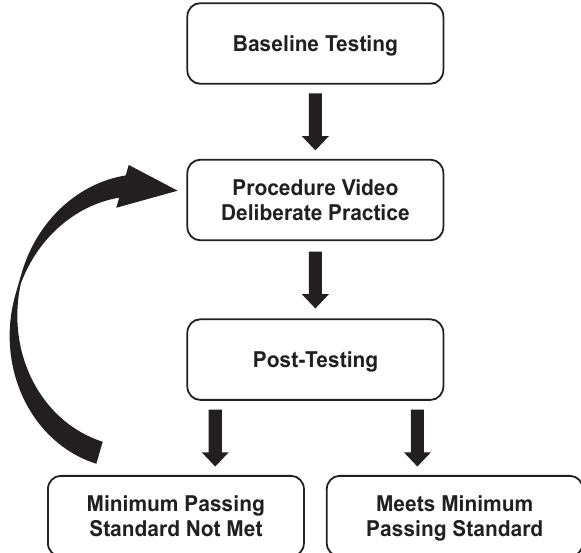
Figure 1. Flow diagram showing the study design using the mastery learning model.